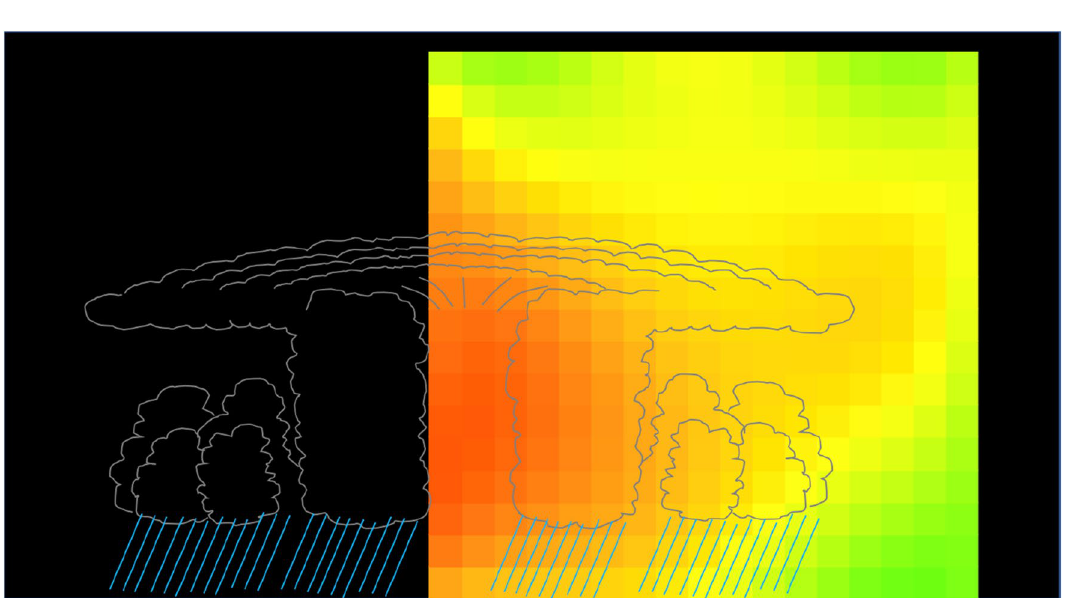
Figure 12. Muographic image of T-1612. The color and angular ranges are the same as in Fig. 10. The position of the centre of the cyclone illustration and its height correspond to the average position and 15 km, respectively. HKMT drew the image with Microsoft PowerPoint software and holds the